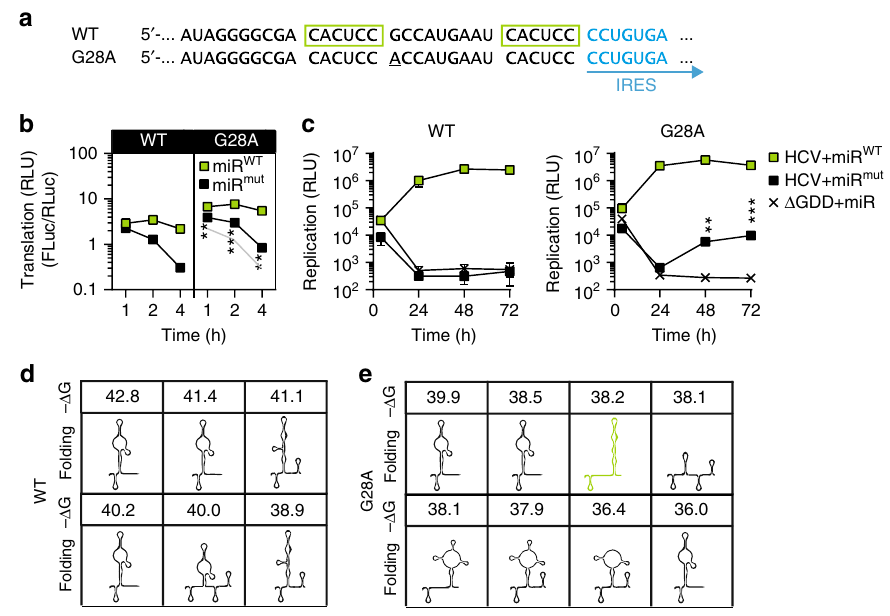
Fig. 7 Impact of natural variants on IRES-mediated translation. a Sequence of the G28A mutant compared to wild type. b Translation assay of WT versus G28A in the presence of miR mut or miR WT . c Replication assay of WT versus G28A in presence of miR mut or miR WT . d Representation of the predicted structural ensemble for the fi rst 120 nt of the WT, as predicted by RNA structure and their respective free energy values ( − Δ G [kcal/mol]). e As in ( d ) for the G28A mutant. Mean values (±SD), n = 3, in technical duplicates. RLU relative light units, Δ GDD replication de fi cient mutant. For the translation assay, statistical signi fi cance of the difference between WT and G28A mutants in presence of miR mut is indicated. The reference graph used to calculate is given in light gray. * P < 0.05, ** P < 0.01, *** P <